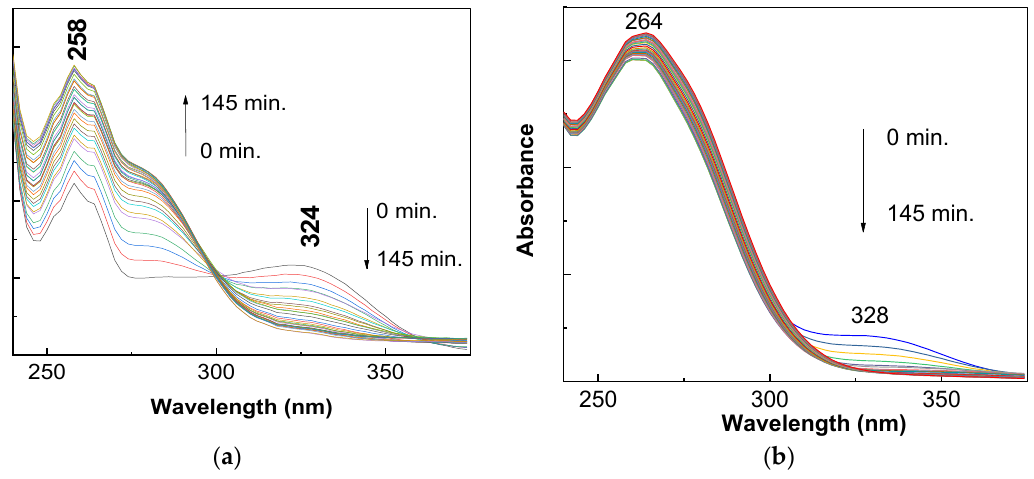
Figure 9. UV-VIS spectra of AM ( a ) and AMP ( b ) reacted with NaOH 0.3 M when the volumetric ratio was equal to 1:2.